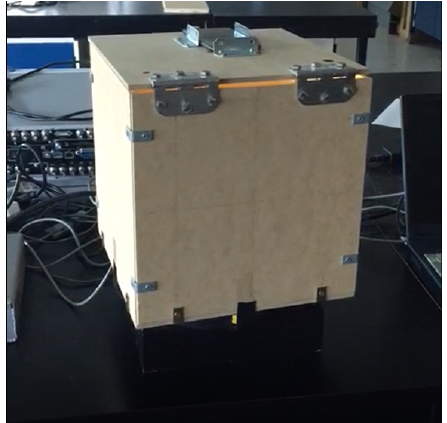
Figure 8. Initial PIVG prototype.